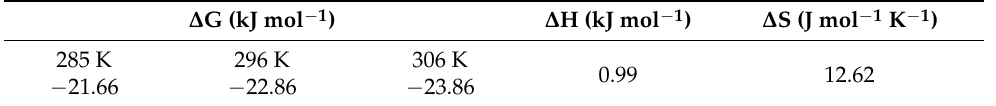
Figure 8. Plot of ln K L vs. 1/T for MB adsorption on DBPH powder.